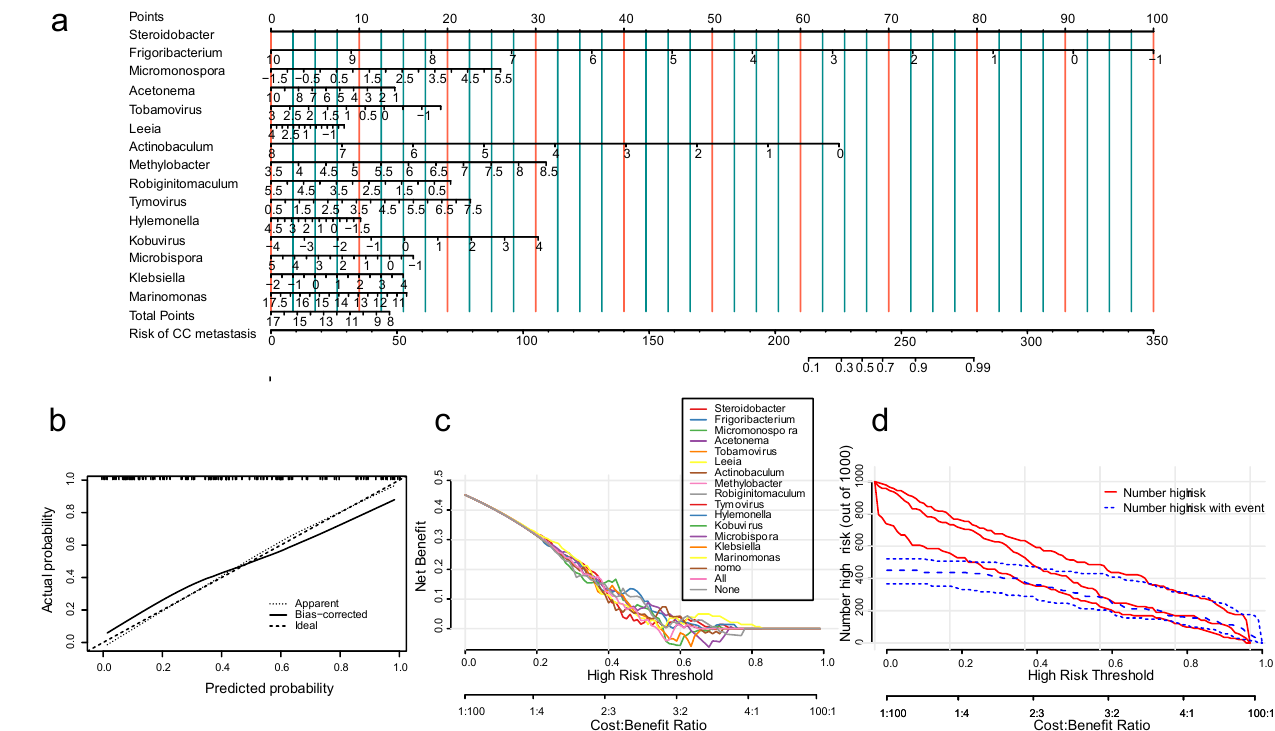
Figure 4. Construction and validation of nomogram models. ( a ) Nomogram model based on 15 microbial features; ( b ) calibration curve of the nomogram; ( c ) clinical decision curve (DCA) of the nomogram; and ( d ) clinical impact curve of the nomogram showing the prediction accuracy and cost-benefit ratio of the nomogram under different risk thresholds.